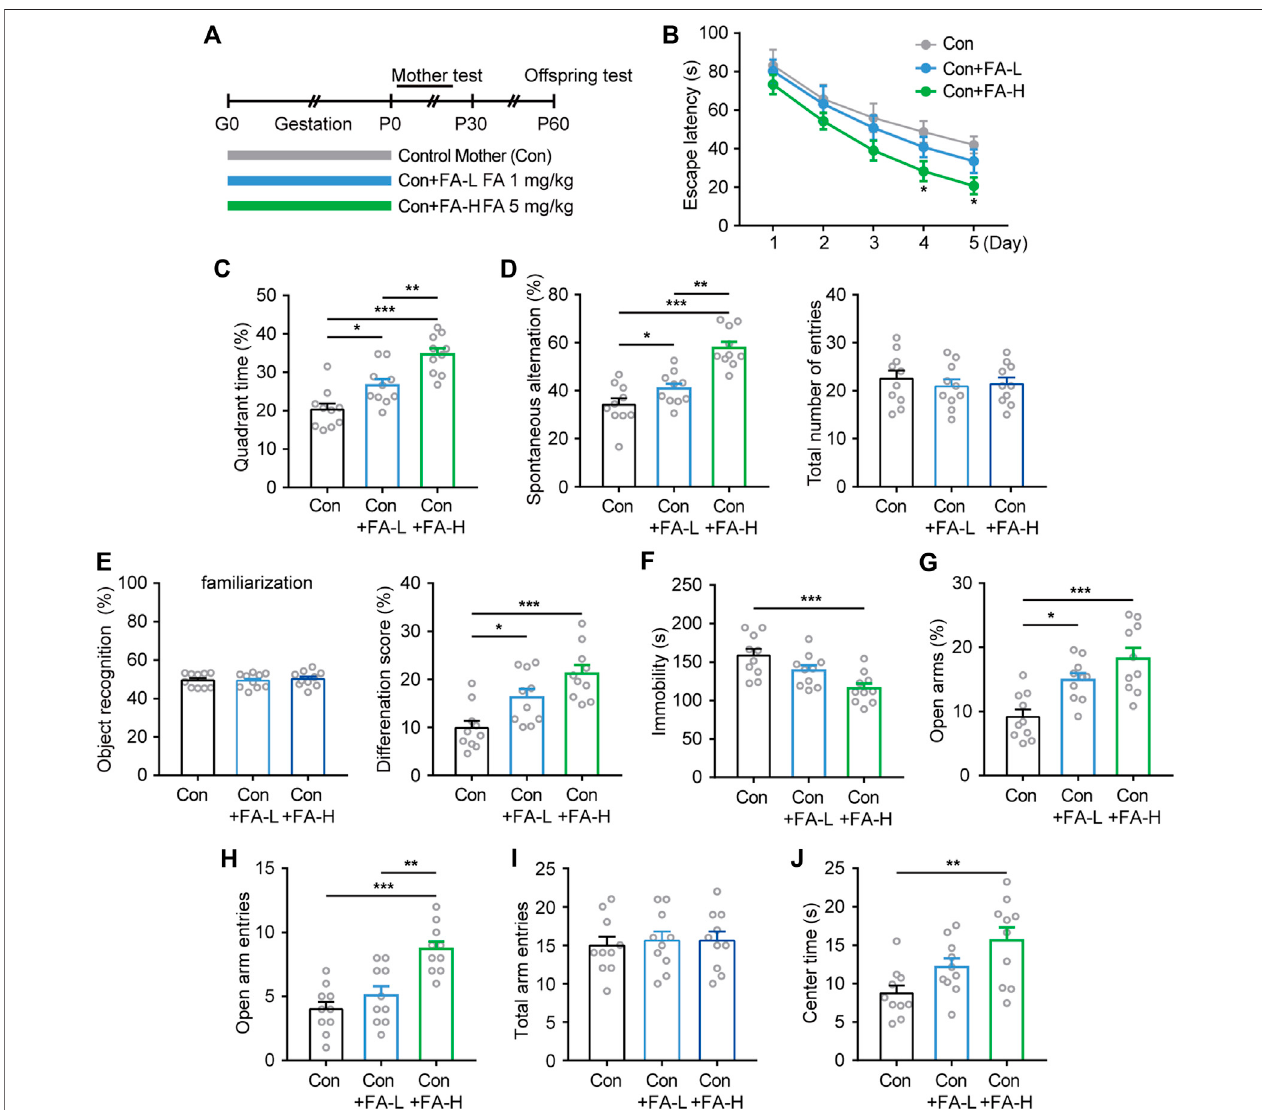
FIGURE 3 | Effects of FA on cognitive- and emotional-related behaviors on postpartum female mice. (A) Schematic diagram of the experimental work fl ow on maternalandoffspring. (B)